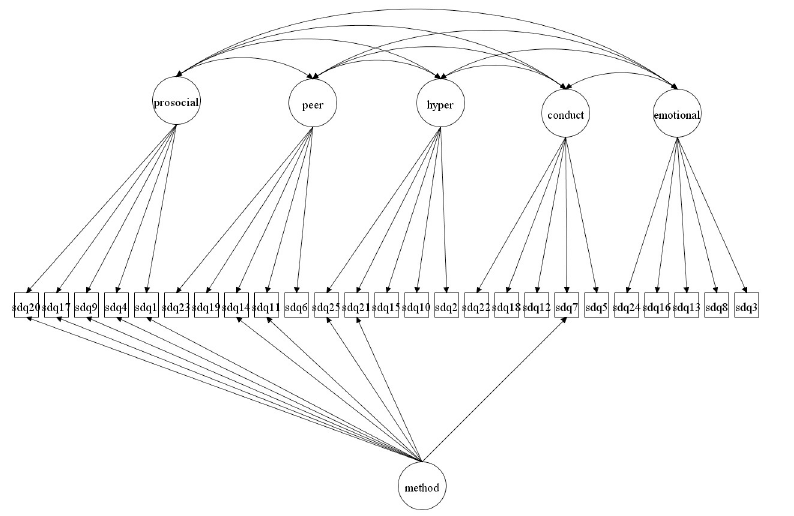
Fig 11. 5-factor model with a separate method factor (Model 6b).